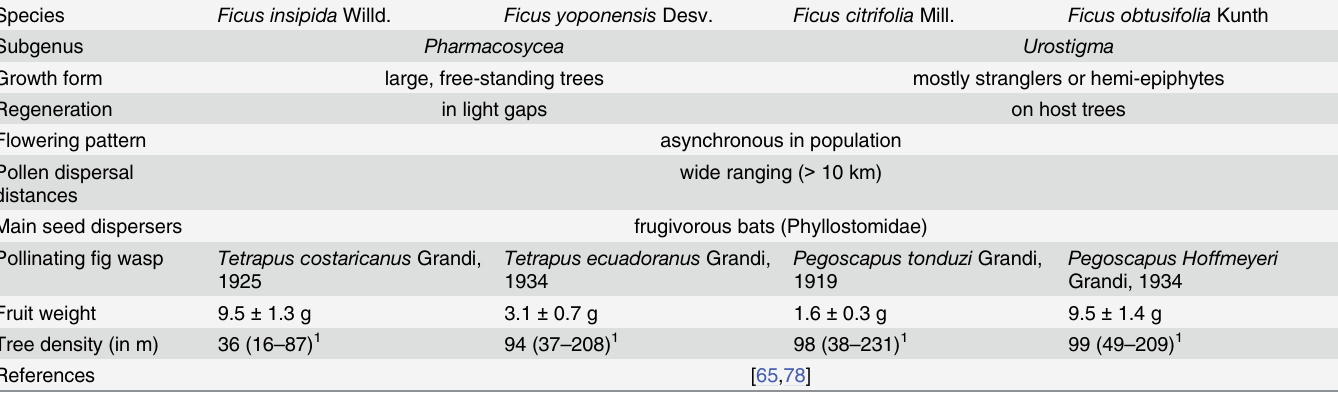
Table 1. Characteristics of the four studied Neotropical Ficus species. Calculation of Nearest Neighbour distance (median with 25th /75th percentile in parentheses) is based on census data by Albrecht, Kalko and Handley. Species Ficus insipida Willd. Ficus yoponensis Desv. large, free-standing trees in light